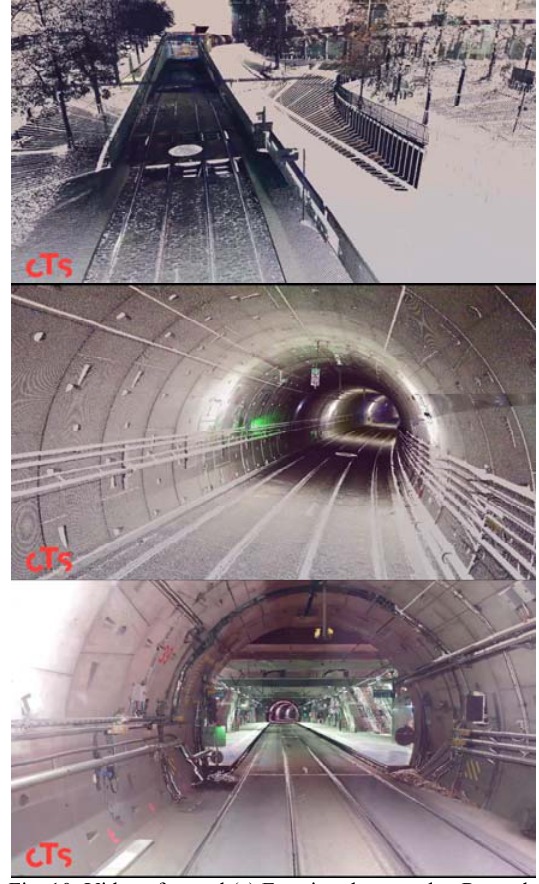
Fig. 10: Video of tunnel (a) Entering the tunnel at Rotonde station, (b) Common section of tunnel, (c) Entering the Gare centrale underground